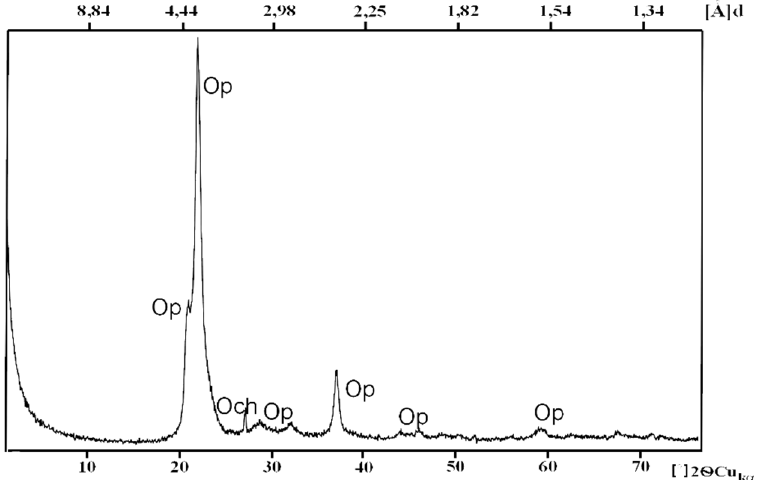
Figure 3. Diffraction pattern of the separated mineral phases. Explanations: Op–opal, Och– chalcedony.